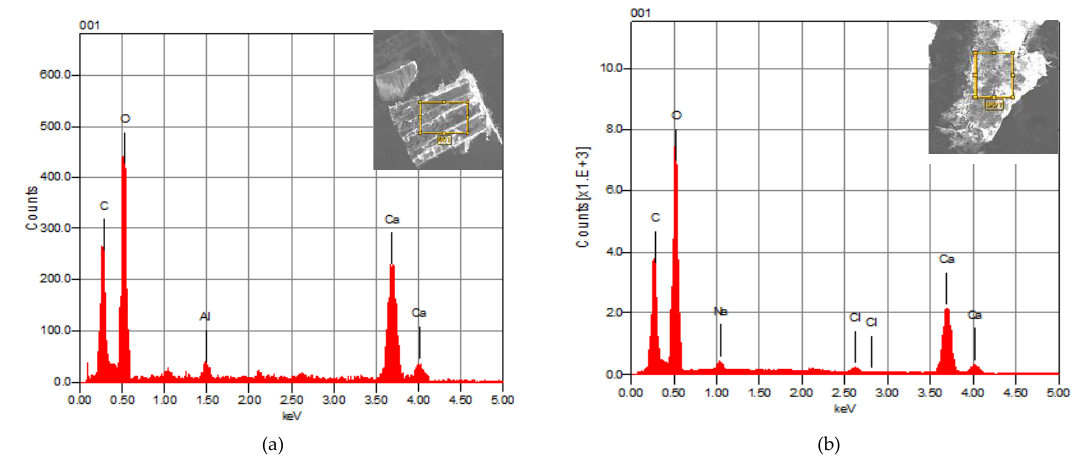
Figure 4. EDX spectra of CB powder ( a ): for 100 μm CB lamellae SEM image and ( b ): for 50 μm CB, dorsal shield SEM image.